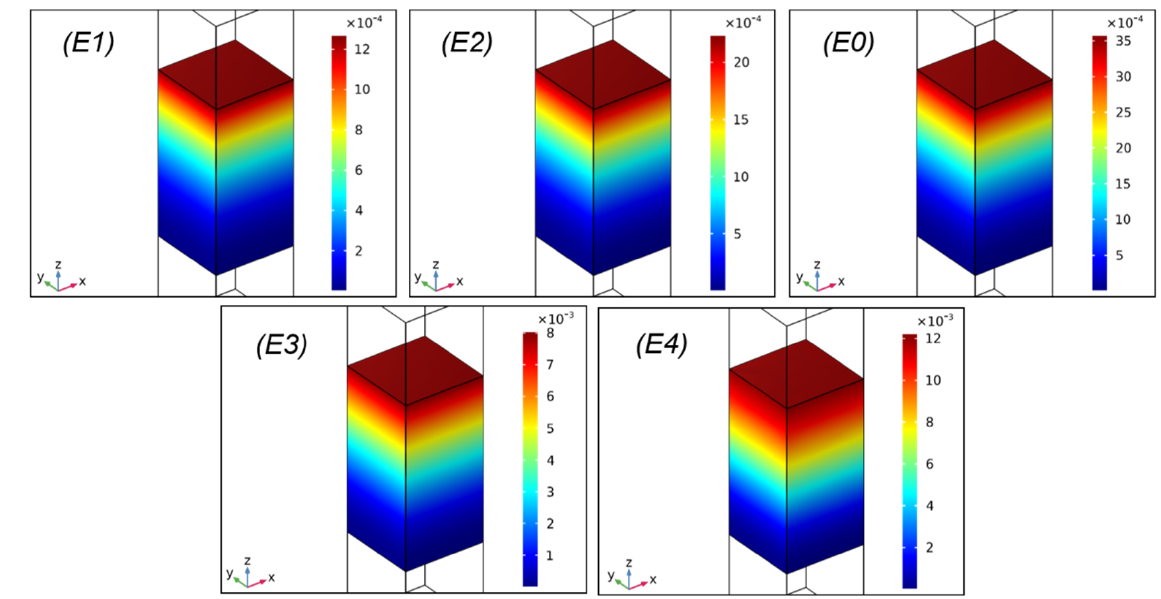
Figure 2. Total power dissipation density (mW/m 3 ) of the PU ‐ based composite with different E’ at 1.5 kHz.